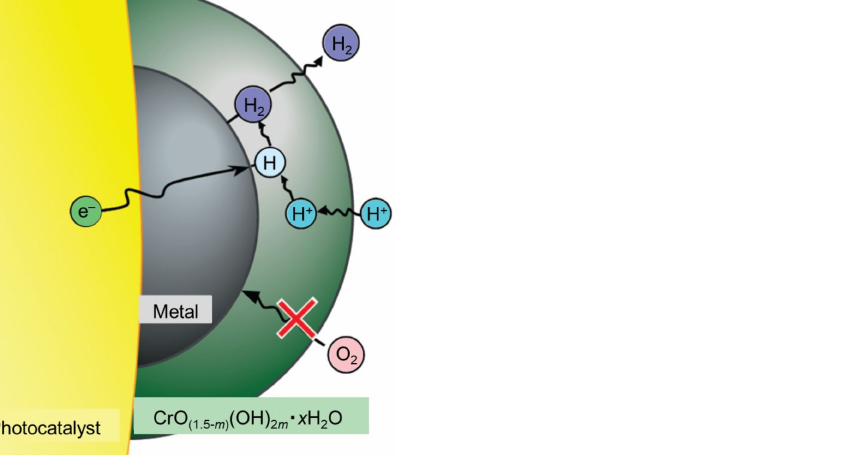
Figure 29. Schematic model of HER on core–shell Cr 2 O 3 /noble-metal NPs system as a cocatalyst for photocatalytic overall water splitting. Reproduced with permission from reference [232]. Copyright 2009 American Chemical